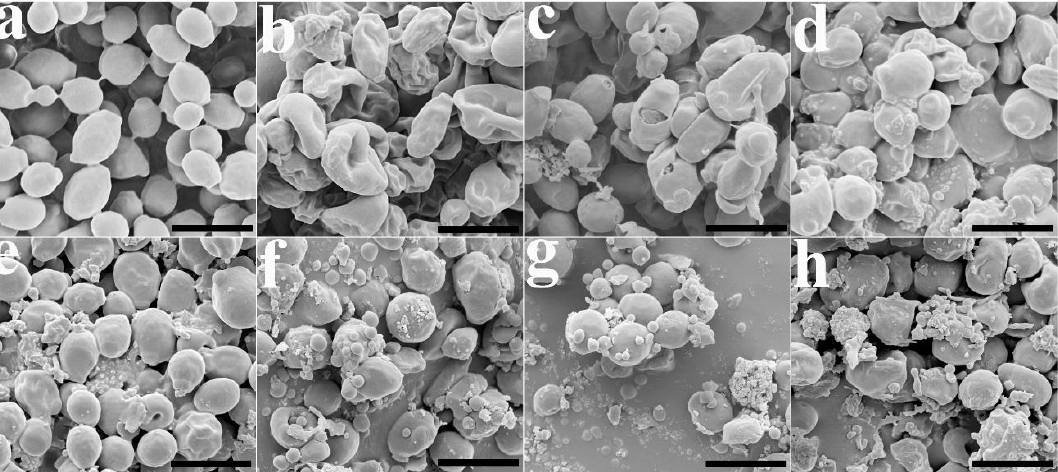
Figure 6. Electron micrographs of C. albicans cells treated with peptides for 1 h at their MICs. ( a ) Control (no treatment); ( b ) histatin 5; ( c ) melittin; ( d ) (HKK) 1 ; ( e ) (HKK) 2 ; ( f ) (HKK) 4 ; ( g ) (HKK) 6 ; ( h ) (HKK) 8 . Bar is 5 µ m.